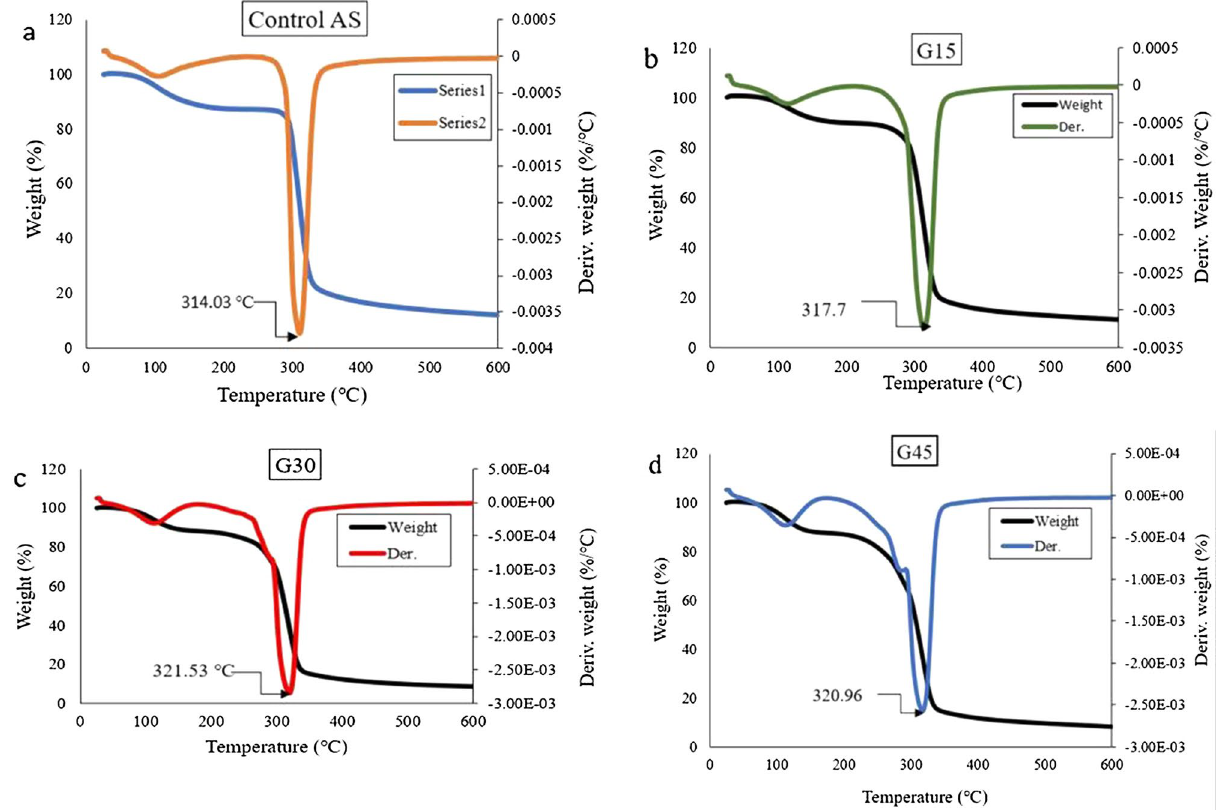
Figure 10. Thermo and derivative curves of control ( a ) AS, ( b ) G15, ( c ) G30, and ( d ) G45-plasticized